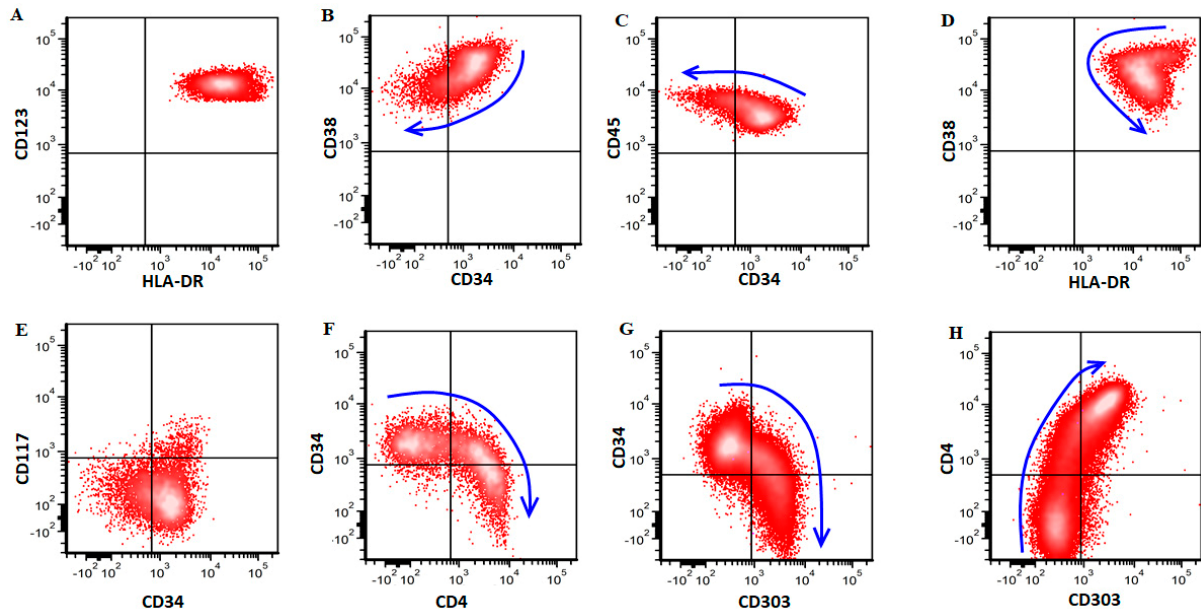
Figure 4. The maturation pattern of pDCs in a case of pDC-AML. pDCs are brightly positive for CD123 ( A ) and HLA-DR ( D ). The earliest pDCs are positive for CD34 ( B , C , F , G ), CD117 (dim, E ), CD123 ( A ) and HLA-DR ( D ). The earliest pDCs are positive for CD34 ( B,C,F,G ), CD117 (dim, E ), CD38 (bright, B ), negative for CD4 ( F,H ) and CD303 ( G,H ). As they mature, the expression of CD34, CD38 and CD117 decreases, and the expression of CD4 and CD303 increases ( H ).